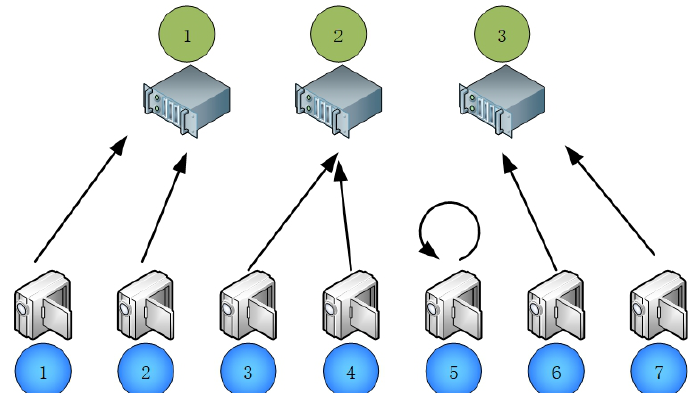
Figure 6. Agent joint-action of 30,000 epoch training. In this scenario, each edge computing node is selected by two devices for computation offload, which achieves the best utilization of resources. At the same time, the device No. 5, with the worst channel state, is selected for local computing. It can be seen that, after 30,000 generations of training, the agent has learned how to make optimal